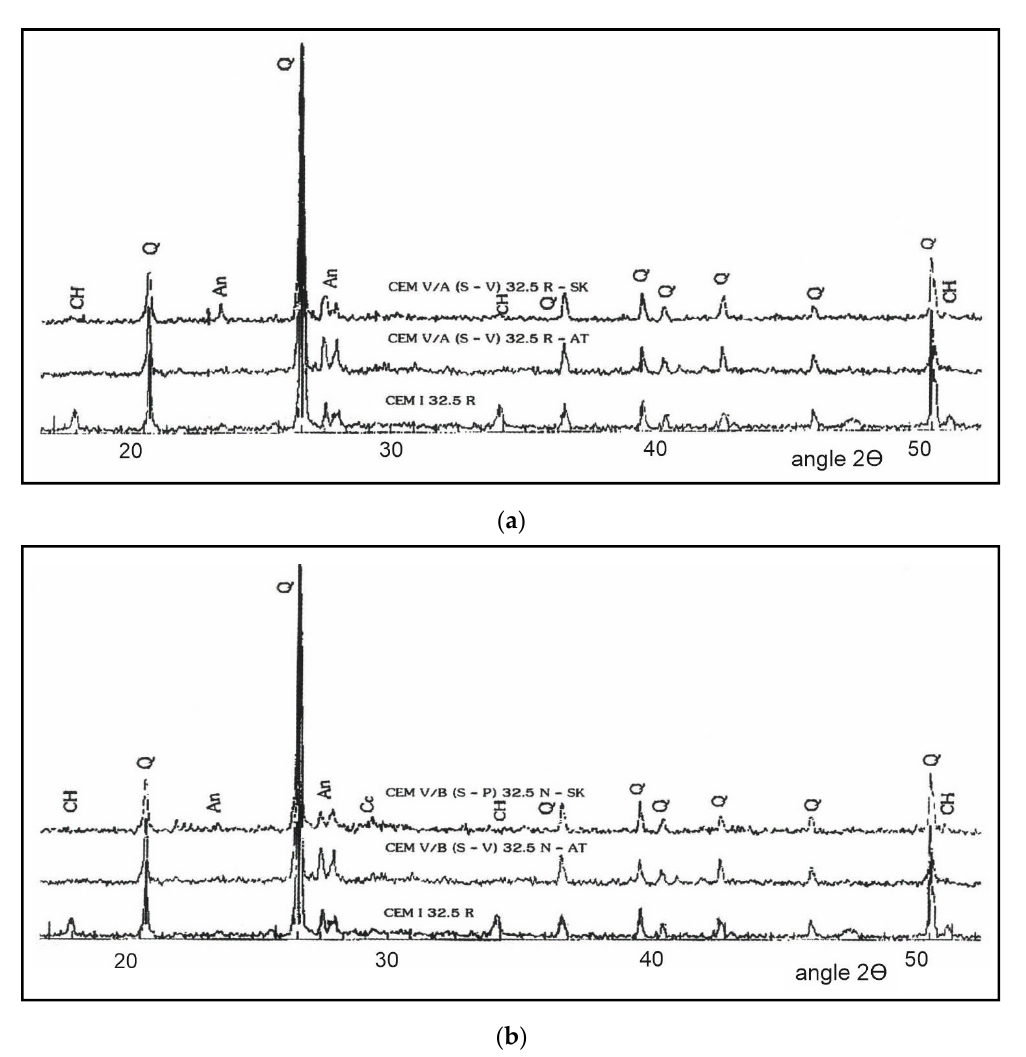
Figure 3. XRD diagrams displaying angle 2 Θ -intensities of ( a ) CEM V/A types and reference cement CEM I and ( b ) CEM V/B types and reference cement CEM Iafter 365 days curing at 20 °C under water,